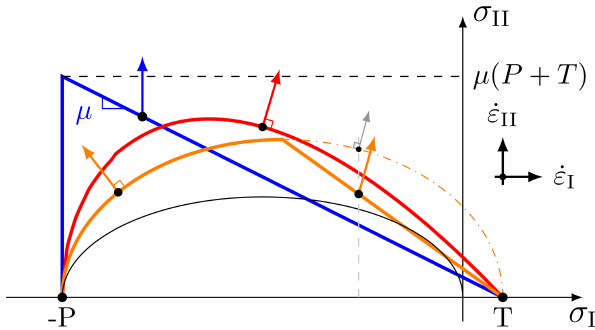
Figure 8. Alternative yield curves and flow rules: the Mohr– Coulomb yield curve with shear (non-normal) flow rule (blue; Ip et al., 1991), the modified Coulombic yield curve with normal (el- liptic part) and non-normal (linear part) flow rule (orange; Hibler and Schulson, 2000), and the teardrop yield curve with a normal flow rule (red; Zhang and Rothrock, 2005). The elliptical yield curve with e F = 2 . 0 is shown for reference (thin black line). P is the compressive ice strength, and T is the tensile ice